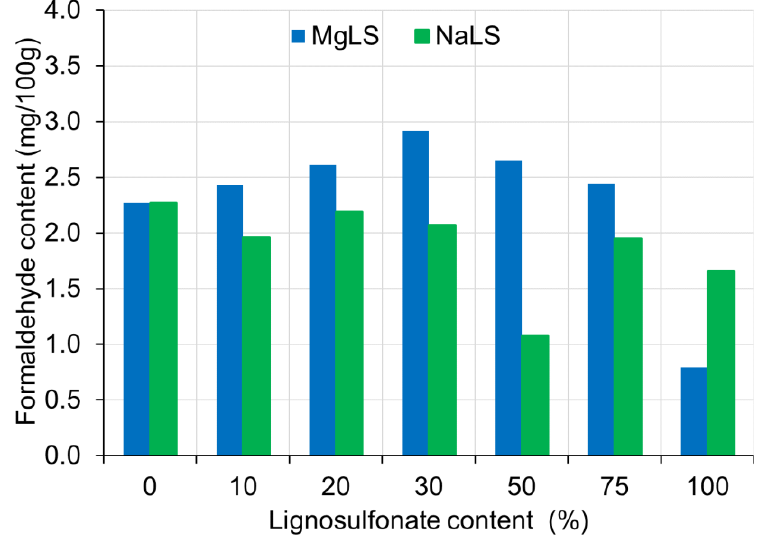
Figure 6. The formaldehyde content of boards made with lignosulfonated-urea-formaldehyde adhesive.